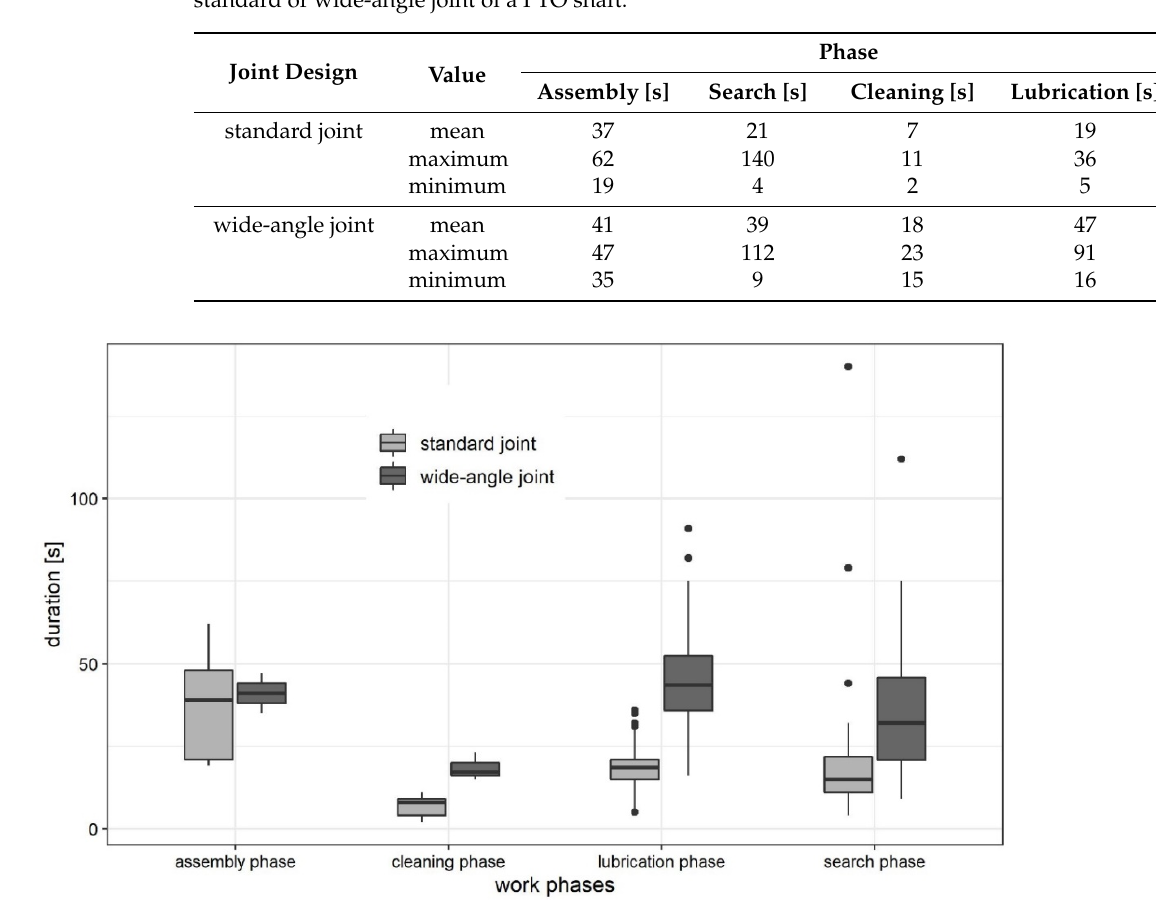
Figure 5. Scattering of the time needed for the work phases by PTO shaft type.